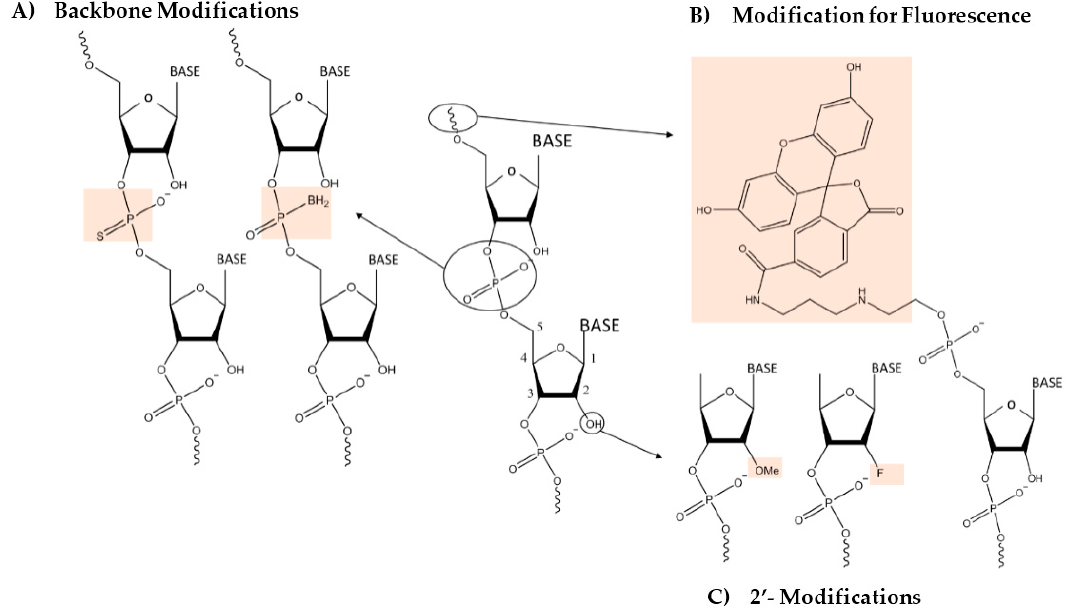
Figure 2. Some examples of RNA chemical modifications which can now be synthesized due to the availability of various synthons compatible with automated nucleic acid synthesizers. ( A ) Modifications in the phosphodiester backbone such as phosphorothioate (S=P)-or-boranophosphate (BH 2 -P); ( B ) Modifications (most commonly at 5’ and 3’) with fluorescence dyes (5’-Fluorescein or 6- FAM in figure) allow for visual detection of RNA-NPCs (RNA-Nanoparticle Complexes), since RNA does not possess intrinsic fluorescence; ( C ) Modifications in the ribose such as in the 2’ position (O- Me, -F and others or ring modified